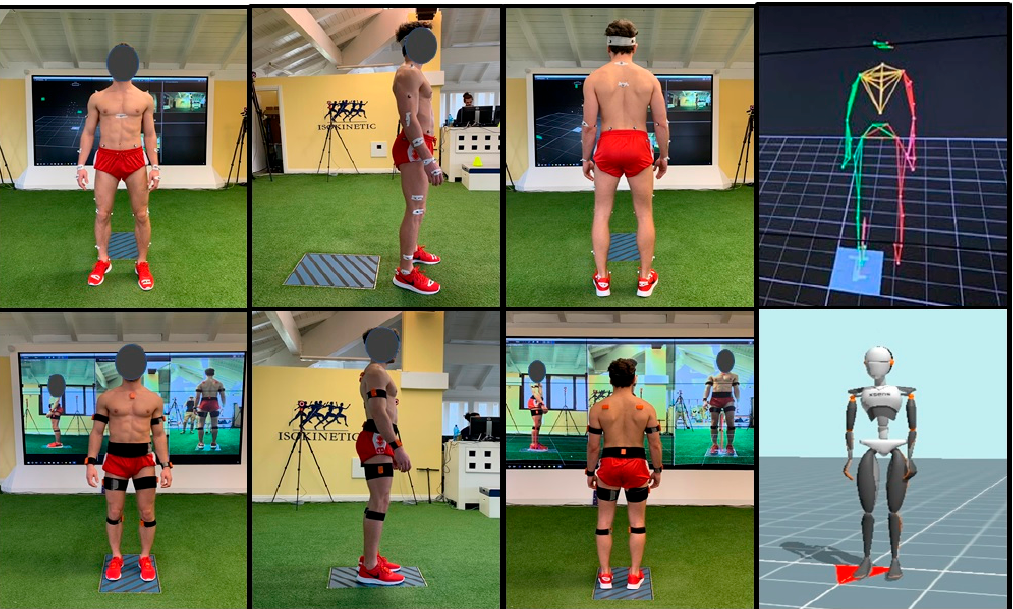
Figure A1. Motion capture systems used in the study: (top row) Plug-in-Gait VICON marker-based protocol in (from left to right) front, side, back, and 3D-environment view; (bottom row) Full Body Xsens inertial sensors protocol in (from left to right) front, side, back, and 3D-environment view.